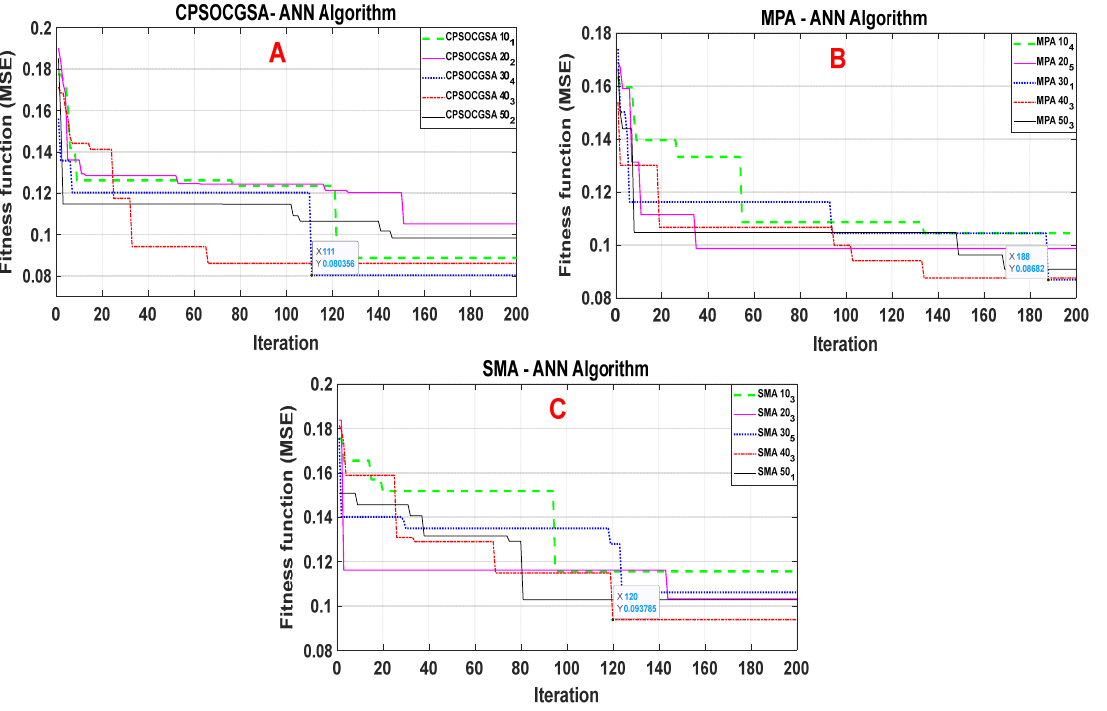
Figure 6. Performance of the CPSOCGSA-ANN, MPA-ANN, and SMA-ANN algorithms for SPI 1.